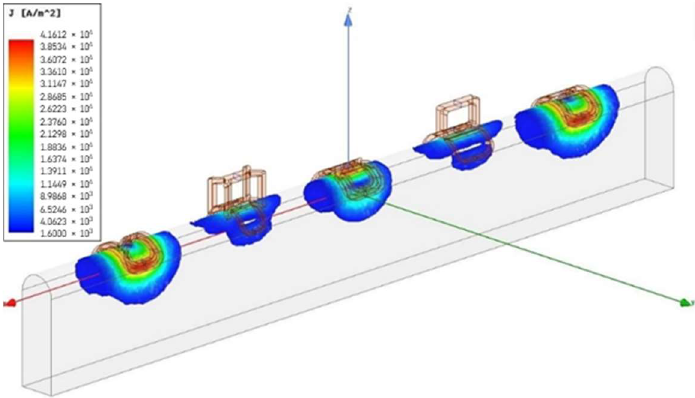
Figure 18. Example of a numerical simulation performed to compare the performance of the five ECT probe concepts. The evaluation of the excitation strength and distribution were the target of this specific simulation.